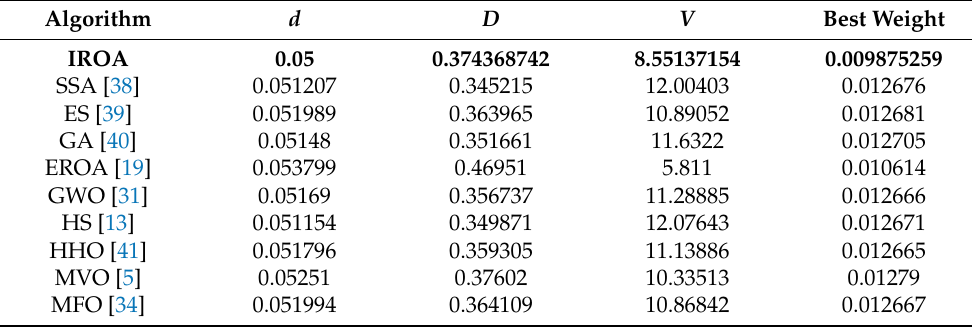
Table 11. Experimental results of tension/compression spring design.